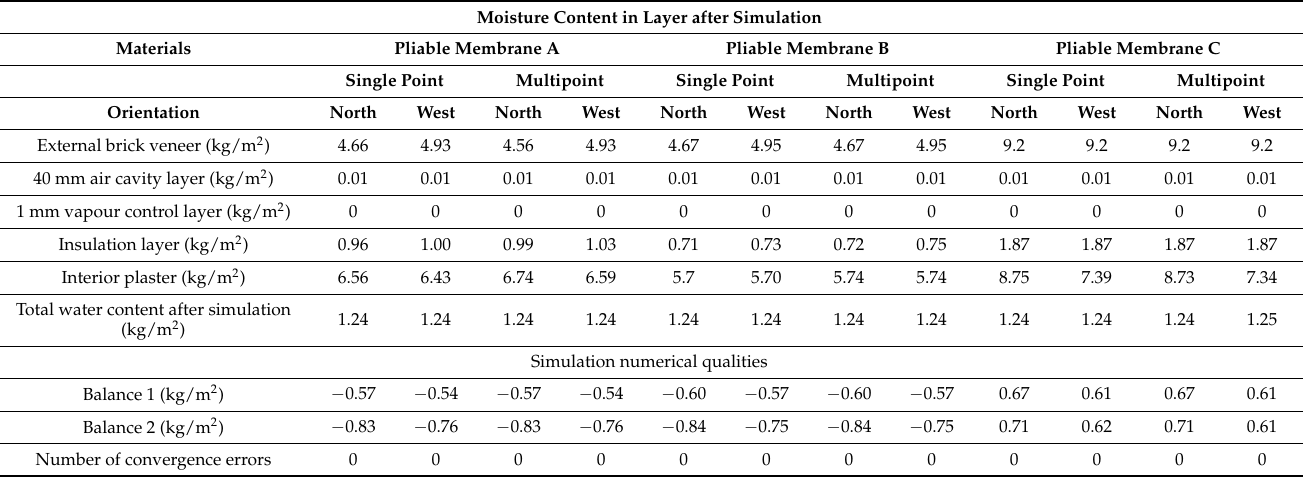
Table A3. Hygrothermal calculation result for Darwin climate on EPW climate file without rain data.